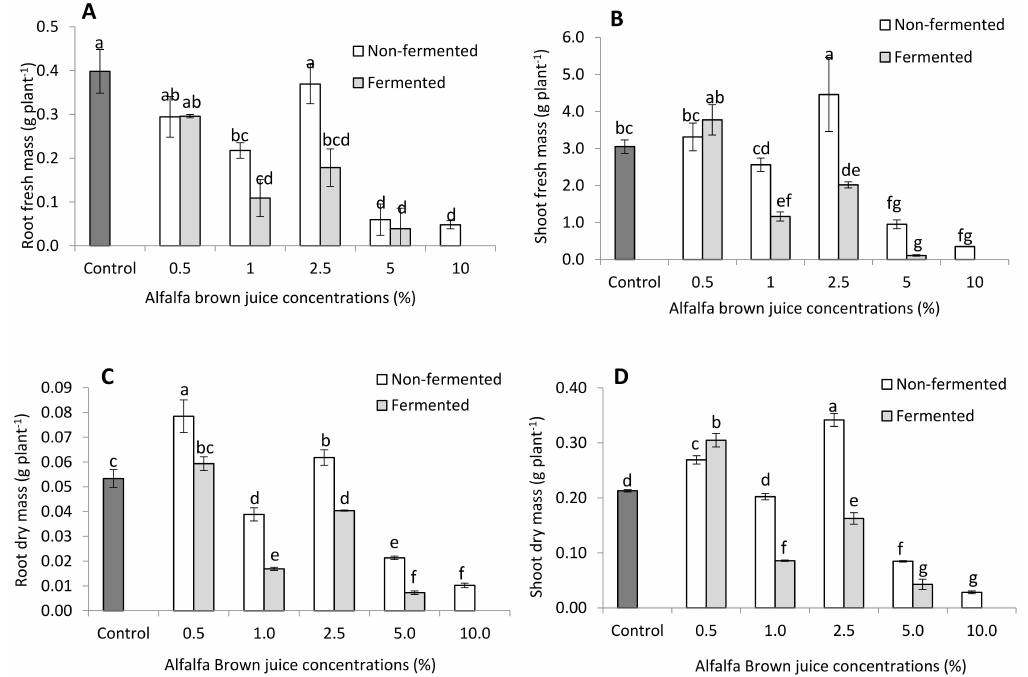
Figure 3. Effect of non-fermented or fermented brown juice (BJ) on the ( A ) root fresh mass, ( B ) shoot fresh mass, ( C ) root dry mass, and ( D ) shoot dry mass of French marigold plants ( n = 3). Different letters on the top of the bars indicate significant differences ( p ≤ 0.05). Data are presented as mean ± standard deviation. Data are absent for 10% fermented BJ treatment due to the inhibitory effect of high BJ concentration; plants